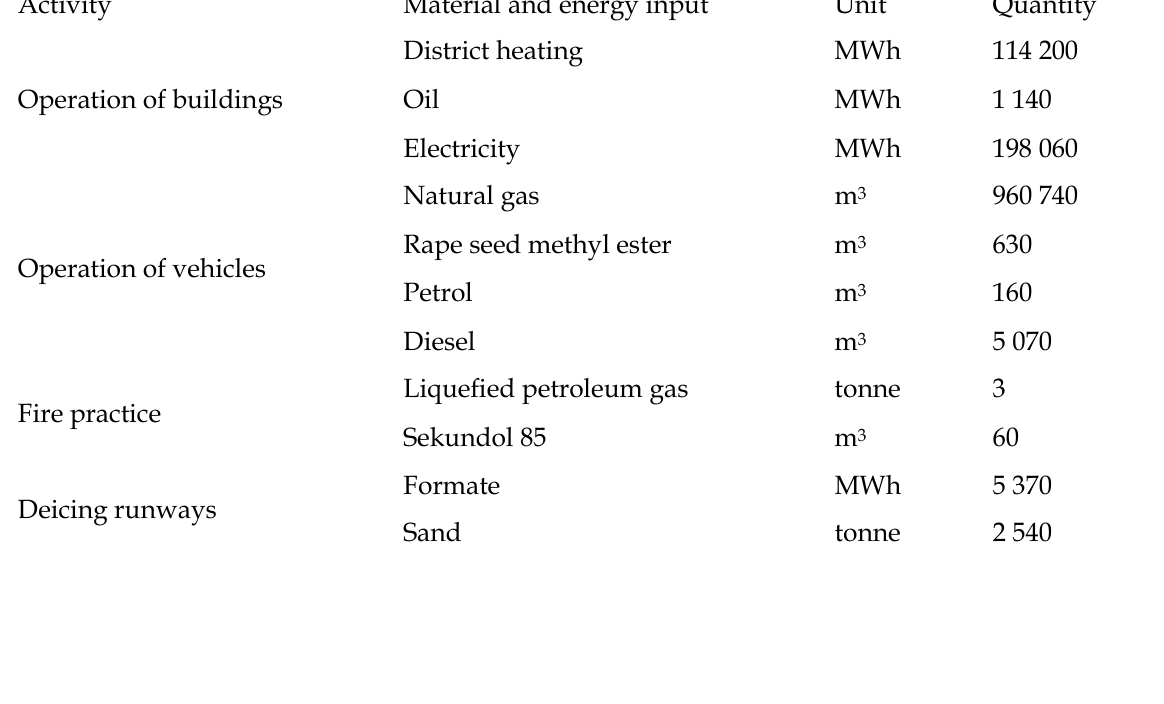
Table A8. Operation of air transport infrastructure: annual material and energy input for different activities. Fuel and electricity use for operation of buildings and vehicles includes also operation of buildings and vehicles used for management of aircraft and energy use for commerce at the airport.